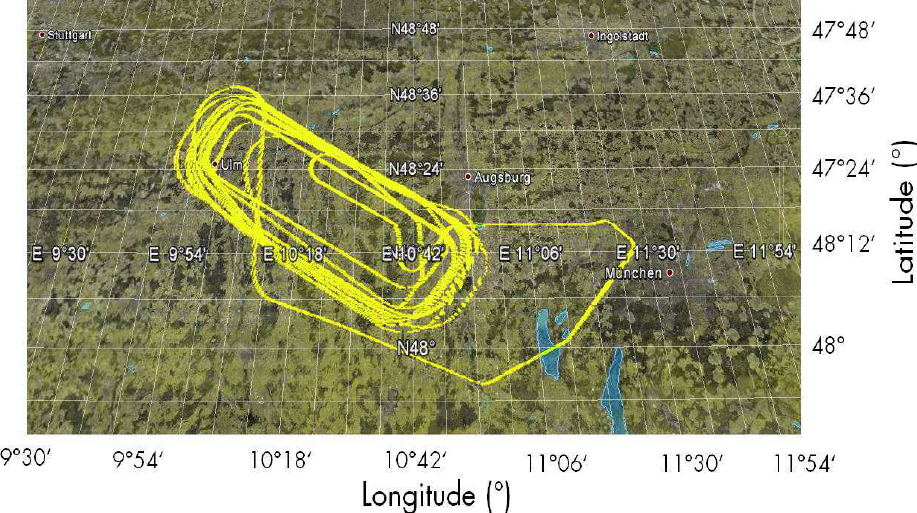
Fig. 3. Flight track of 3 November 2010 over the measurement area in southern Germany (illustrated using Google Earth). corresponds to a footprint at the surface of 1 km 2 including the flight movement for 14 km flight